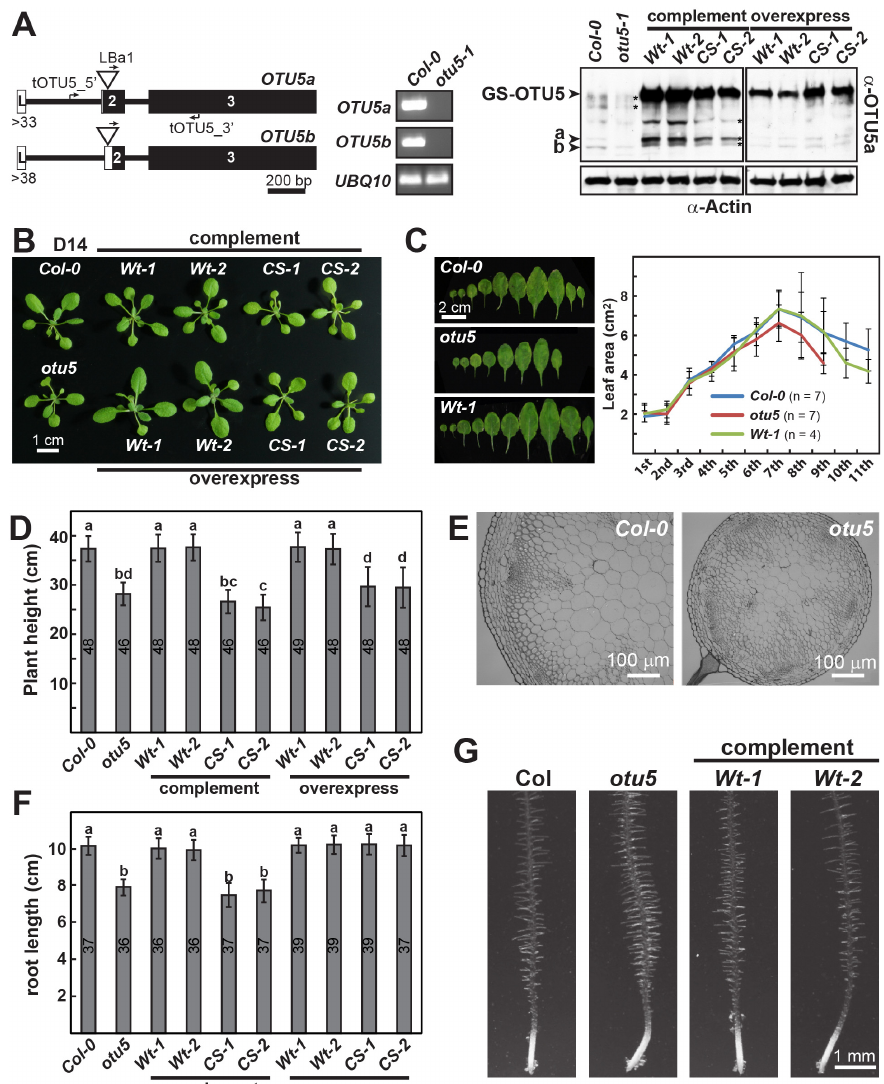
Figure 1. Vegetative growth phenotypes of otu5-1 mutant plants. ( A ) Full-length OTU5a and OTU5b transcripts and their encoded proteins were not detected in otu5-1 . Left, schematic diagrams showing the T-DNA insertion sites (triangles, not in scale) in OTU5a and OTU5b . Exons are denoted by numbers in boxes, with coding regions shaded in black; introns are indicated by lines. L, leader exon. The positions of the genotyping primers tOTU5_5 ′ , tOTU5_3 ′ , and T-DNA left border primer LBa1 are indicated (Table S4). Middle, expression of the full-length OTU5a and OTU5b transcripts was examined by RT-PCR in Col-0 and otu5-1 . The UBQ10 -amplified fragment served as a loading control. Right, expression of OTU5 isoforms (a and b, arrowheads) in Col-0 and otu5-1 and expression of N-terminal GS-tagged wild-type and catalytic site-mutated OTU5a (GS-OTU5, arrowhead) in complemented and overexpressing lines ( Wt-1 , Wt-2 , CS-1 , and CS-2 ). Nonspecific background signals are marked with asterisks. The source of these unspecific signals has not been investigated. Immunoblotting using α -OTU5b was performed with total protein extracts isolated from 15-day- old seedlings. Duplicated samples were analyzed using antisera against actin ( α -Actin) to verify equal loading. ( B ) Representative seedlings 14 DAS (Col-0, otu5-1 , and various complemented and overexpressed lines). ( C ) Reduced number and size of rosette leaves in otu5-1 plants. A representa- tive set of rosette leaves at 27 DAS in order of production is shown for Col-0, otu5-1 , and a GS- OTU5a-complemented otu5-1 line (left). Average area of each rosette leaf in order from 4–7 plants of Col-0, otu5-1 , and a GS-OTU5a-complemented otu5-1 line at 27 DAS (right). ( D ) Average plant heights of Col-0, otu5-1 , and various complemented and overexpressed lines at 45 DAS ( n = 46–49). ( E ) Representative toluidine blue-stained sections of primary inflorescence stems for Col-0 and otu5- 1 plants. ( F ) Average primary root lengths of seedlings for Col-0, otu5-1 , and various complemented and overexpressed lines grown under long-day conditions at 12 DAS ( n = 36–39). ( G ) Representative root tips of seedlings for otu5-1 , Col-0, and two complemented lines at seven DAS grown under phosphate-replete conditions. Different letters denote significant differences by pairwise compari- son using Student’s t -test; error bars indicate standard deviations.